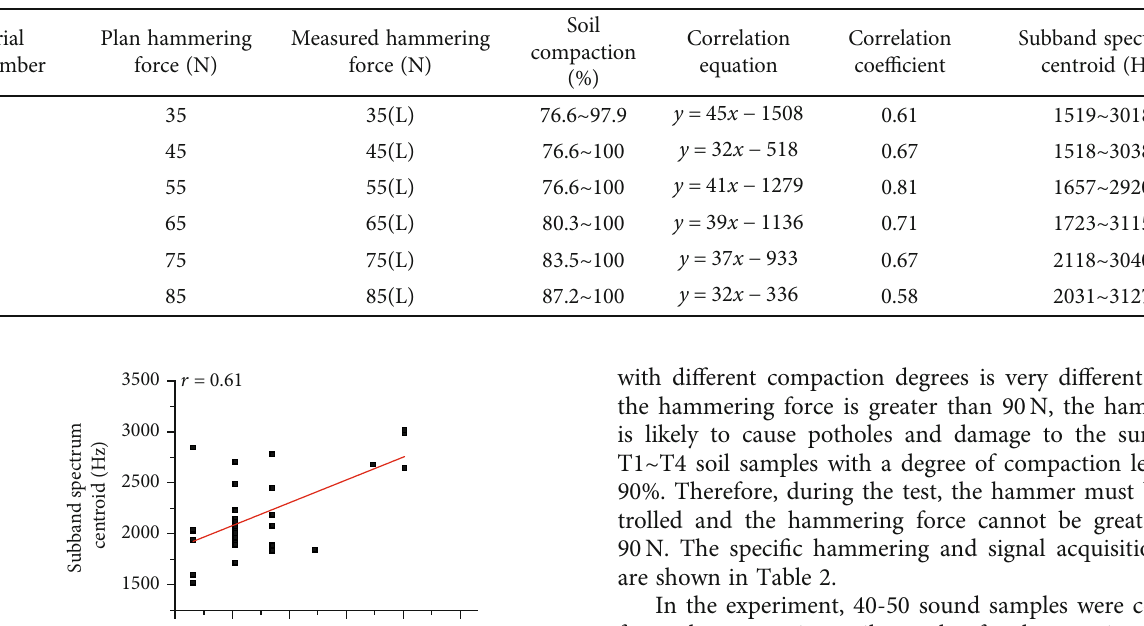
Table 3: Statistical table of correlation analysis between di ff erent compaction of soil samples and subband spectral centroid under di ff erent hammering